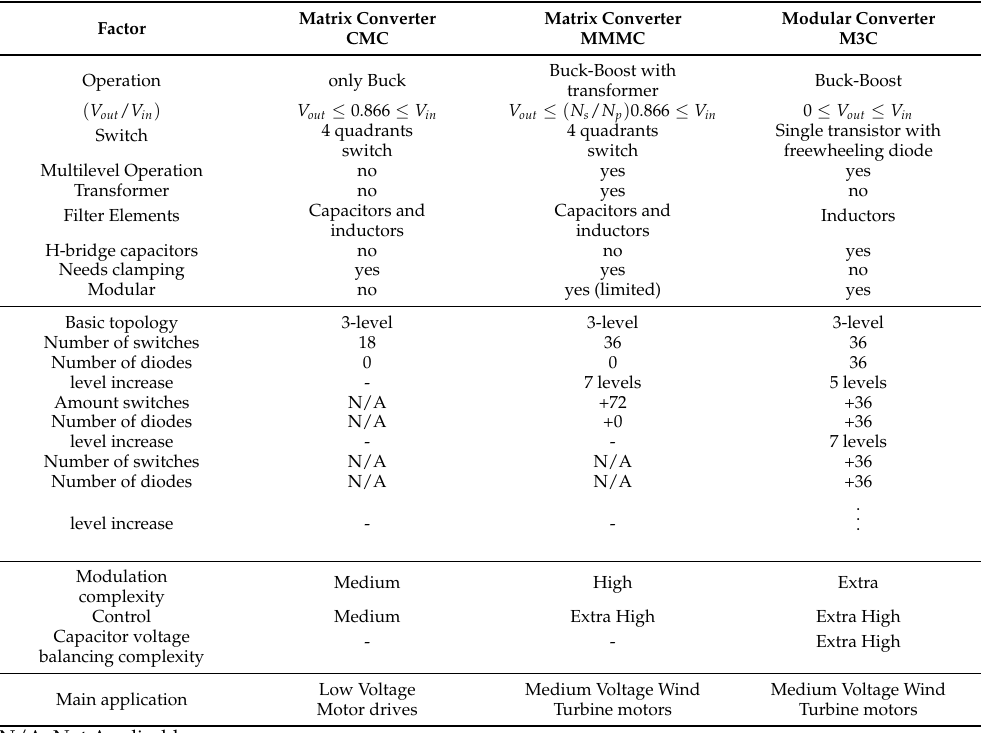
Table 6. Comparison between CMC, MMMC, and M3C